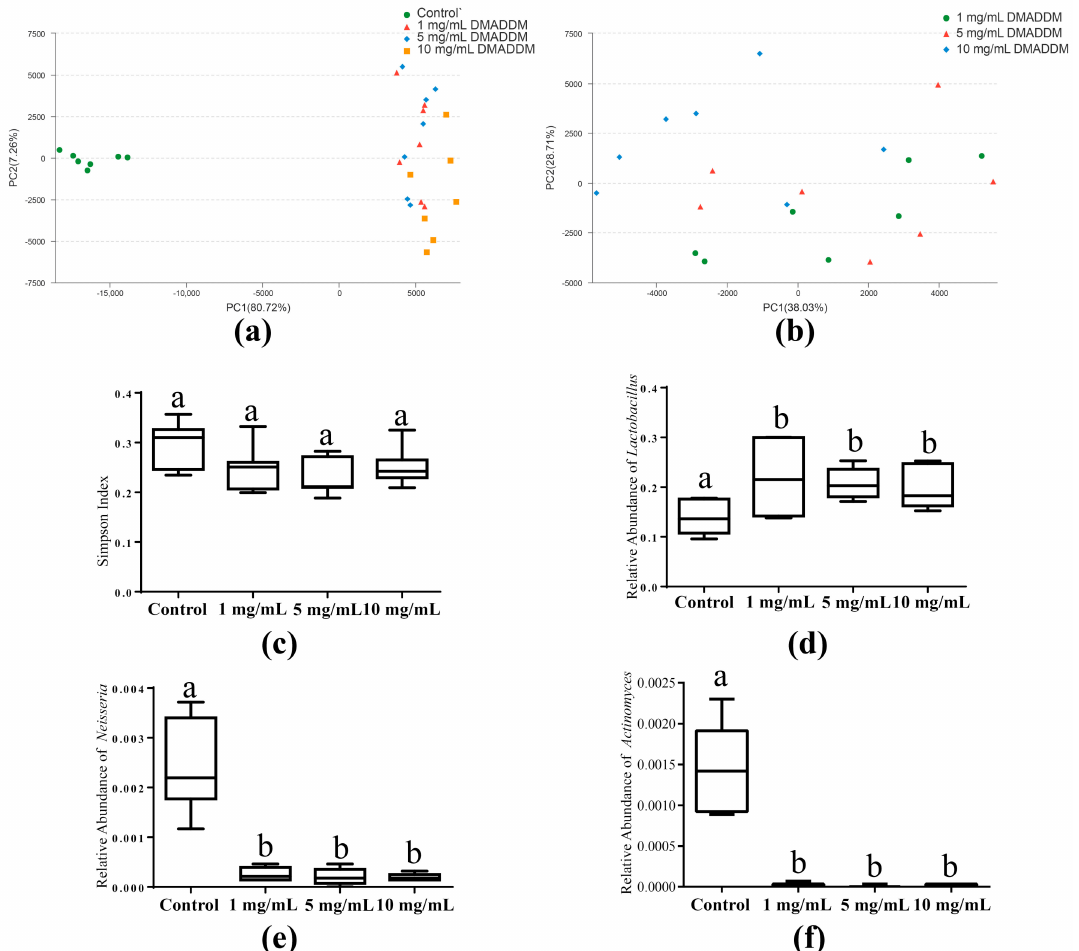
Figure 3. The microbial community of saliva-derived biofilms. ( a ) Principal component analysis (PCA) score plot of control group (green), 1 mg/mL DMADDM group (red) 5 mg/mL DMADDM group (blue) and 10 mg/mL DMADDM group (yellow); ( b ) PCA score plot of 1 mg/mL DMADDM group (green) 5 mg/mL DMADDM group (yellow) and 10 mg/mL DMADDM group (blue); ( c ) Alpha diversity of every group was measured with the Simpson index; ( d – f ) showed the relative abundance of Lactobacillus , Neisseria , and Actinomyces , respectively. Significant difference can be seen between the bars marked with different letters (a, b) ( p <